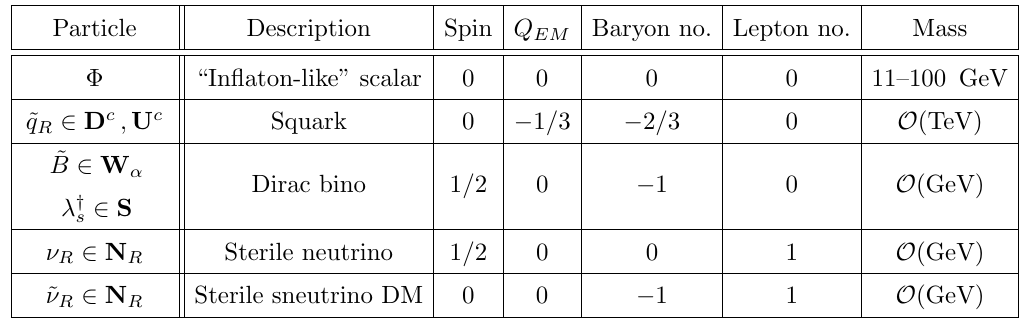
Table 2. Summary of the component (cid:12)elds and their charge assignments, properties, and the super(cid:12)eld in which they are embedded. We work in terms of Weyl spinors so that the Dirac bino consists of two components = ( ~ B; (cid:21) y ). Here, (cid:8) is an \in(cid:13)aton-like" (cid:12)eld that decays s out of equilibrium producing b and (cid:22) b quarks. The heavy colored squark ~ q R is integrated out to mediate quark-bino four fermion interactions (note that various (cid:13)avors of squarks may generate this interaction, as will be discussed further below). The Dirac bino mediates decays of hadrons into the dark sector. The dark sector is embedded into a right-handed neutrino supermultiplet where the sneutrino is stable and represents our DM candidate, while the sterile neutrino generally decays on time scales of interest for collider